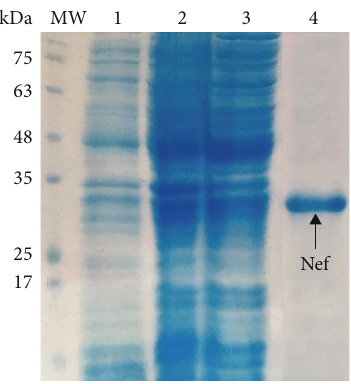
Figure 3: Expression and puri fi cation of HIV-1 Nef protein in Rosetta : lane 1: before induction; lane 2: 5 hours after induction with IPTG (1 mM); lane 3: 16 hours after induction with IPTG (1 mM); lane 4: the puri fi ed Nef protein; MW: molecular weight marker (prestained protein ladder, 10-180 kDa,